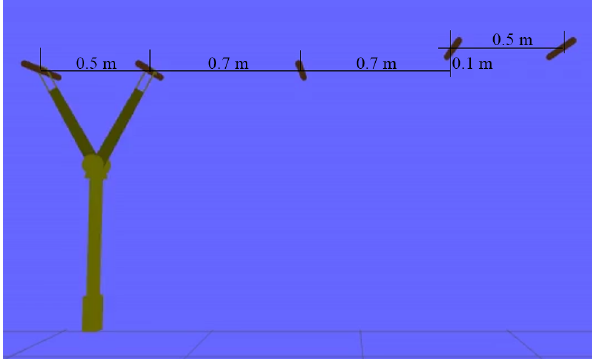
Figure 8. The simulation environment in